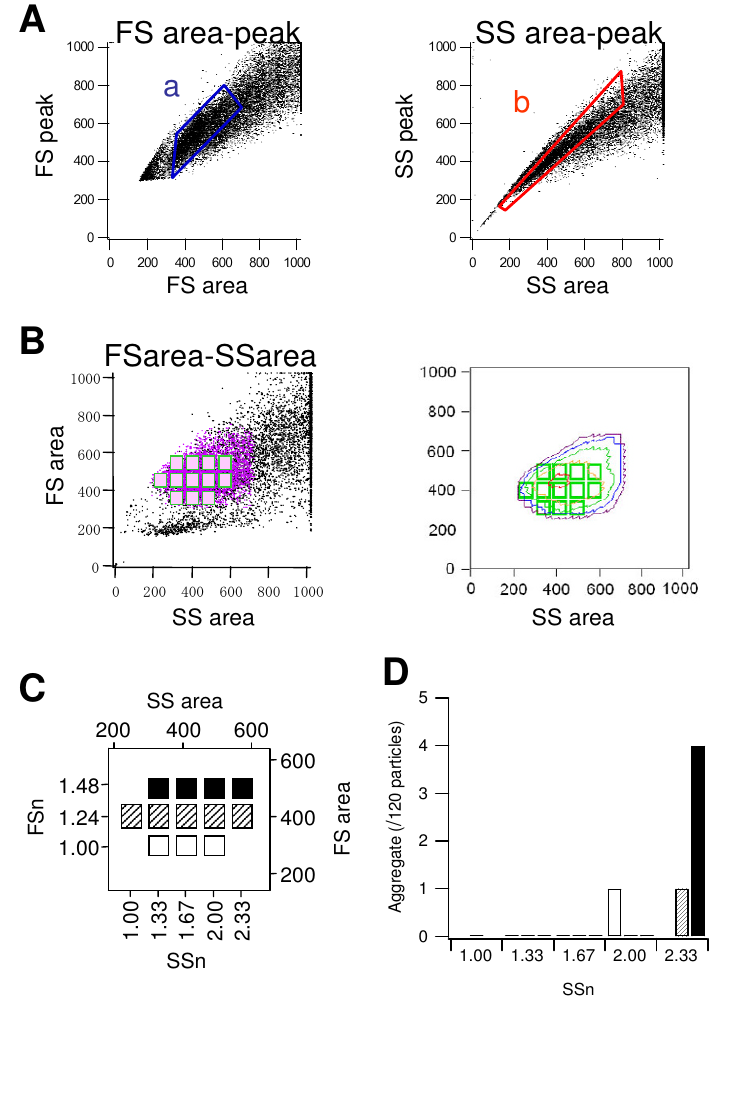
Figure 4 Living- and single-cell gates and the twelve subfractions . A: Living and single cell-rich gates in FSarea-FSheight (a, blue) and SSarea-SSheight (b, red) are shown. B: SSarea-FSarea profile. Left: dot plot of all cells (black) and cells in the a and b gates (purple dots). Right: contour plot of the cells in the a and b gates. The twelve sorting gates are represented by the green rec- tangles. C: Schematic representation of the twelve gates. SSarea and FSarea values were normalized to the smallest value and represented as SSn and FSn . D: The number of aggregate cells in the twelve subfractions (n = 120). The SYTO24-stained nuclei in the sorted cells were counted. Shading corresponds to that in